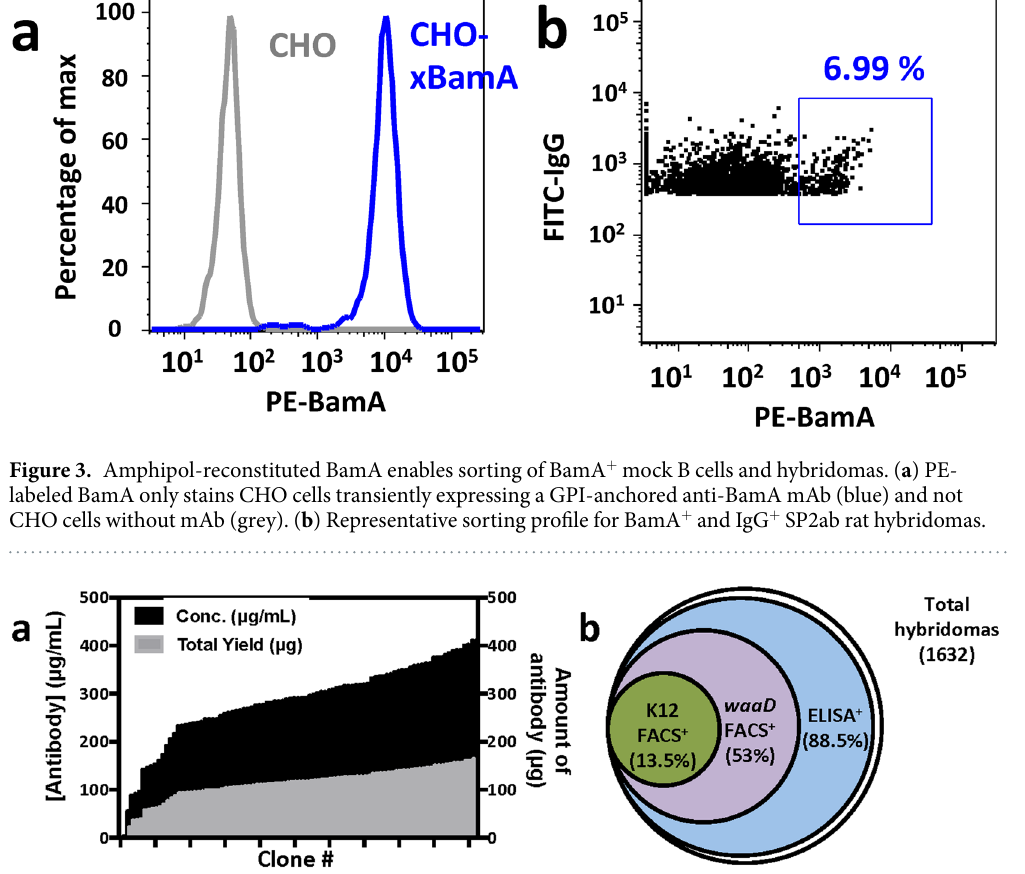
Figure 4. Sorting hybridomas with amphipol- BamA followed by high-throughput hybridoma production yields large panel of purified BamA + mAbs. ( a ) Representative yields (~100 μ g on average; grey bars) and final purified concentrations (~150 μ g/mL on average; black bars) from one plate of purified hybridomas. ( b ) Panel of 1632 BamA-sorted purified hybridomas is highly enriched for BamA binding by ELISA (~88.5%), Δ waaD FACS (53%), or even K12 FACS